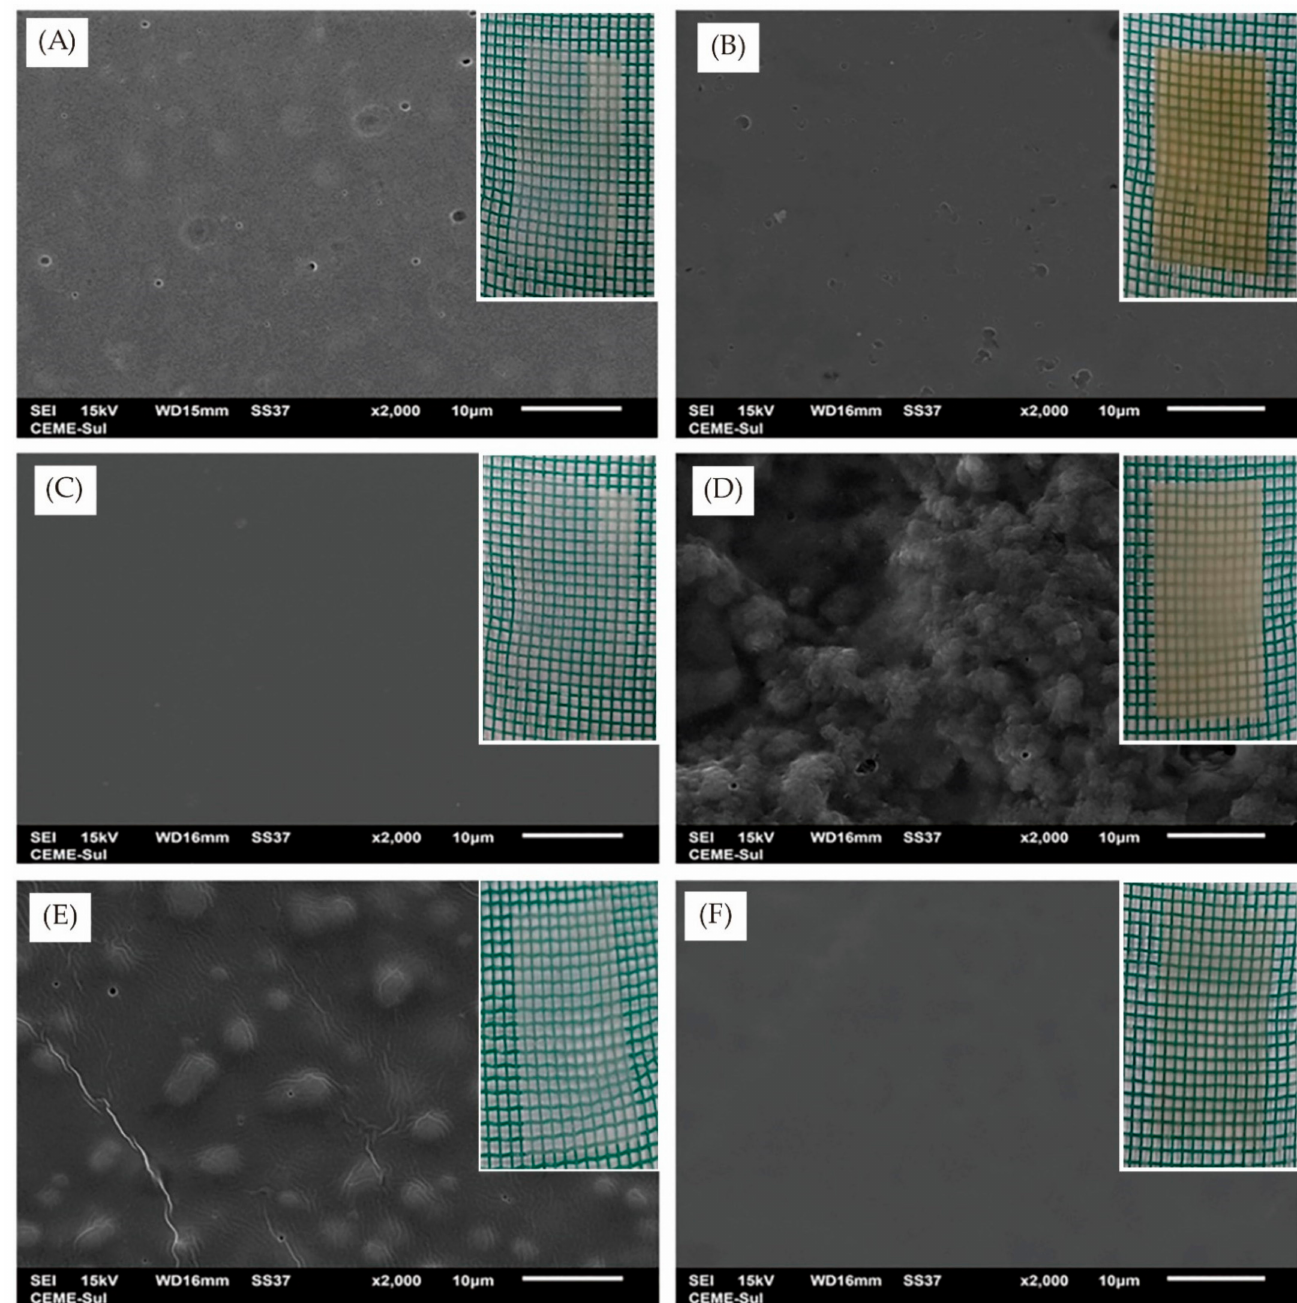
Figure 4. Scanning electron microscopy images ( × 2000) and physical photos of different edible films. ( A ) Collagen film; ( B ) Whey protein film; ( C ) Methylcellulose film; ( D ) Collagen/whey protein blend film; ( E ) Collagen/methylcellulose blend film; ( F ) Whey protein/methylcellulose blend film. (Adapted with permission from Filipini [91]; published by John Wiley and Sons,